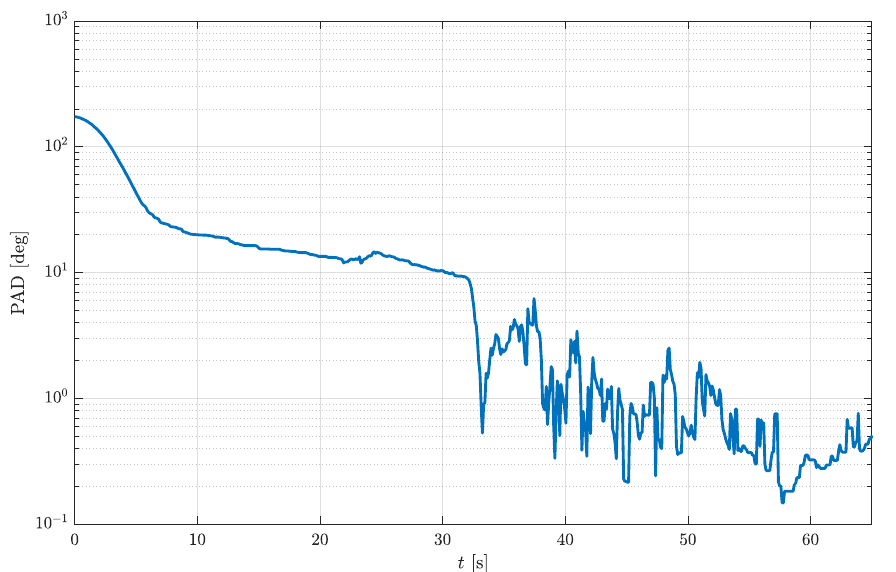
Figure 11. PAD between the estimated rotational quaternions for both sets of